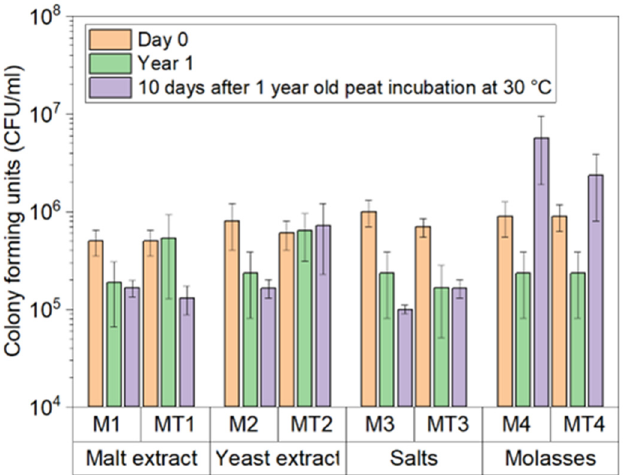
Figure 5. CFU counts in peat after 1 year of storage at 15 ◦ C. After 356 days, peat stored at 15 ◦ C was stored at 30 ◦ C for 10 days, after which CFU analyses were performed. Medium